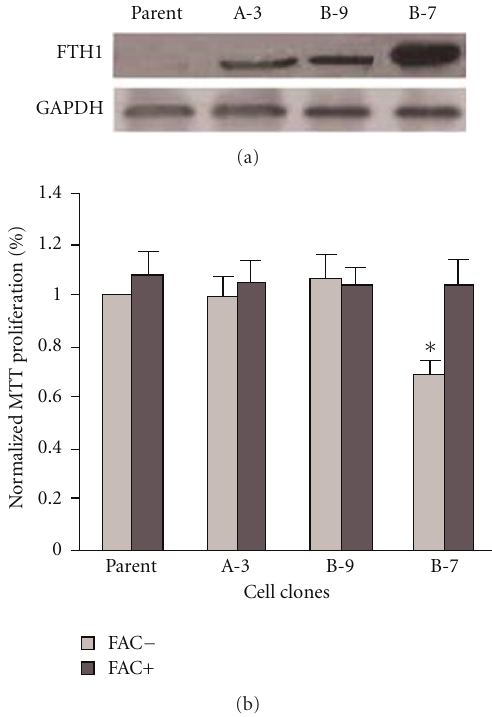
Figure 4: E ff ects of FTH1 overexpression on cell proliferation in other two clones. (a) FTH1 expression in di ff erent cell clones was measured by western blot assay. (b) E ff ect of FTH1 overexpression on cell proliferation. MTT assay was used to assess the e ff ect of FTH1 overexpression on cell proliferation. Data were normalized by those in parent cells without FAC supplementation. Data were expressed as mean ± SD from 3 experiments. Parent cells grown in absence of FAC were set as control. ( ∗ P < 0 .